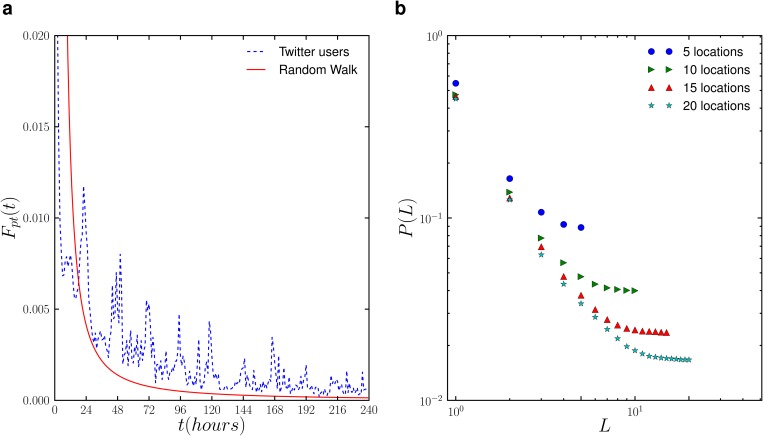
Return dynamics of Twitter users: (a) The probability of return of users to a given locational; (b) preferential return to previously visited locations.